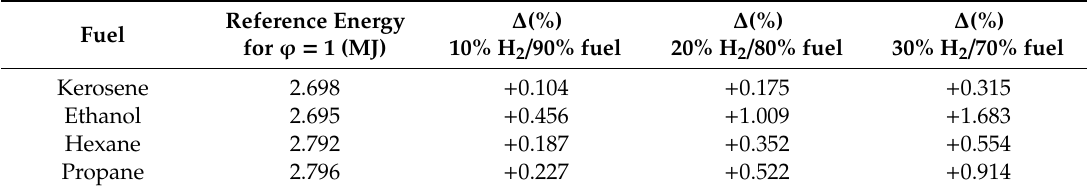
Table 6. Calculated chemical energy content in 1 kg of stoichiometric fuel–air mixture with hydrogen addition to fuel (by